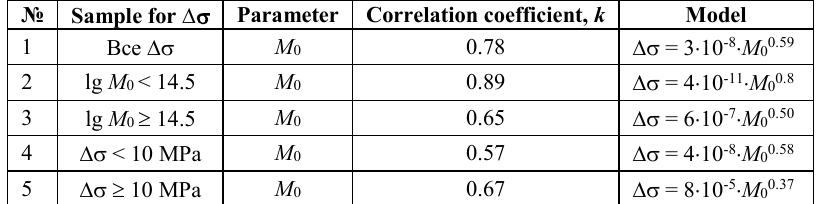
Fig. 10 . Distribution of stress drop depending on the logarithm of the scalar moment: a - for events with lg M 0 < 14.5 - black color, lg M 0  14.5 - crimson color; b - for events with ∆  < 10 - black color, for ∆   10 MPa - crimson. Table 4. Regression dependences and correlation coefficients of dynamic parameters of earthquake sources and their magnitude and seismic